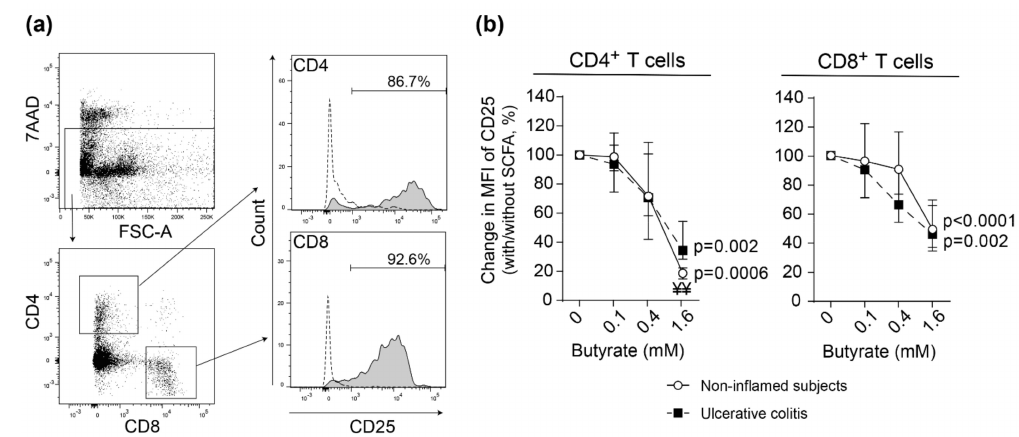
Figure 3. Effects of butyrate on lamina propria T cell proliferation and activation. Lamina propria (LP) cells were stimulated with anti-CD3 and anti-CD28 with increasing concentrations of butyrate (0–1.6 mM) for 48 h and analyzed by flow cytometry. ( a ) Gating strategy using LP cells from a non-inflamed subject. Live LP cells (7AAD − ) were gated into CD4 + and CD8 + T cells (left panel) and further gated for activated cells (CD25). Dotted line shows cells cultured without anti-CD3 and anti-CD28. ( b ) Change in CD25 median fluorescent intensity (MFI) in stimulated CD4 + ( left ) and CD8 + ( right ) T cells from inflamed sigmoid colon of UC patients ( n = 4) and sigmoid colon of non-inflamed subjects ( n = 6). Data are shown as median and interquartile range. Comparisons between non-inflamed subjects and UC are denoted with ¥ where ¥¥ <